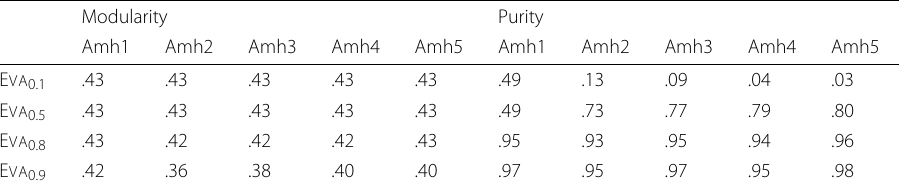
Table 3 Multi-nominal: summary of modularity and purity scores on the Amherst network labeled with different number of attributes Modularity Purity Amh1 Amh2 Amh3 Amh4 Amh5 Amh1 Amh2 Amh3 Amh4 Amh5 E VA 0.1 .43 .43 .43 .43 .43 .49 .13 .09 .04 .03 E VA 0.5 .43 .43 .43 .43 .43 .49 .73 .79 .80 E VA 0.8 .43 .42 .42 .42 .95 .93 .95 .94 .96 E VA 0.9 .42 .36 .38 .40 .40 .97 .95 .97